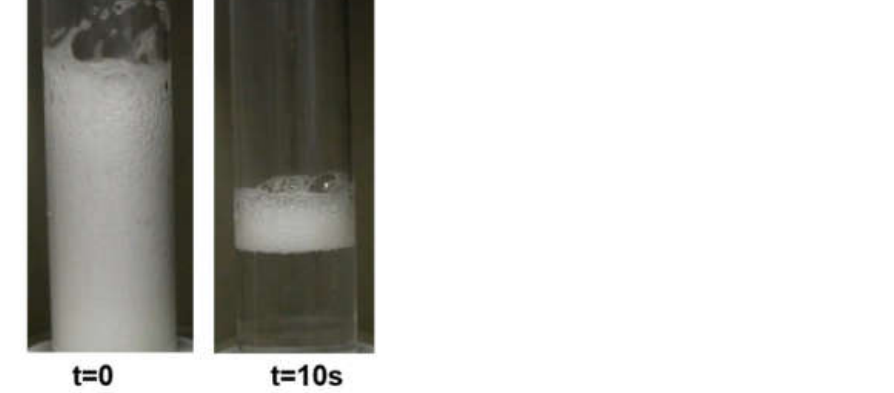
of lauroyl ethyl arginate 100 pp, chitosan 100 ppm in the presence of 1%wt acetic acid and the mixture of lauroyl ethyl arginate 100 ppm with chitosan 100 ppm in the presence of 1%wt acetic acid. There is a well-outlined difference between single-component and mixed solutions. In the case of the lauroyl ethyl arginate 100 ppm solution (Figure 2a), only unstable thick films are formed. Some of the chitosan-only solutions’ films are stable and have an equilibrium thickness of 52 ± 4 nm (Figure 2b); they rupture at a critical pressure of P cr ~90 ÷ 105 Pa and h = 29 ÷ 30 nm. Another portion of the films is less stable and ruptures at P cr ~15 Pa and at equilibrium thickness values. However, the films of LEA and chitosan mixtures are stable with equilibrium thickness values of 84.4 ± 3.5 nm (Figure 2c); critical pressures reach P cr ~6000 Pa, and the critical film thickness values are h ~ 30 nm (Figure